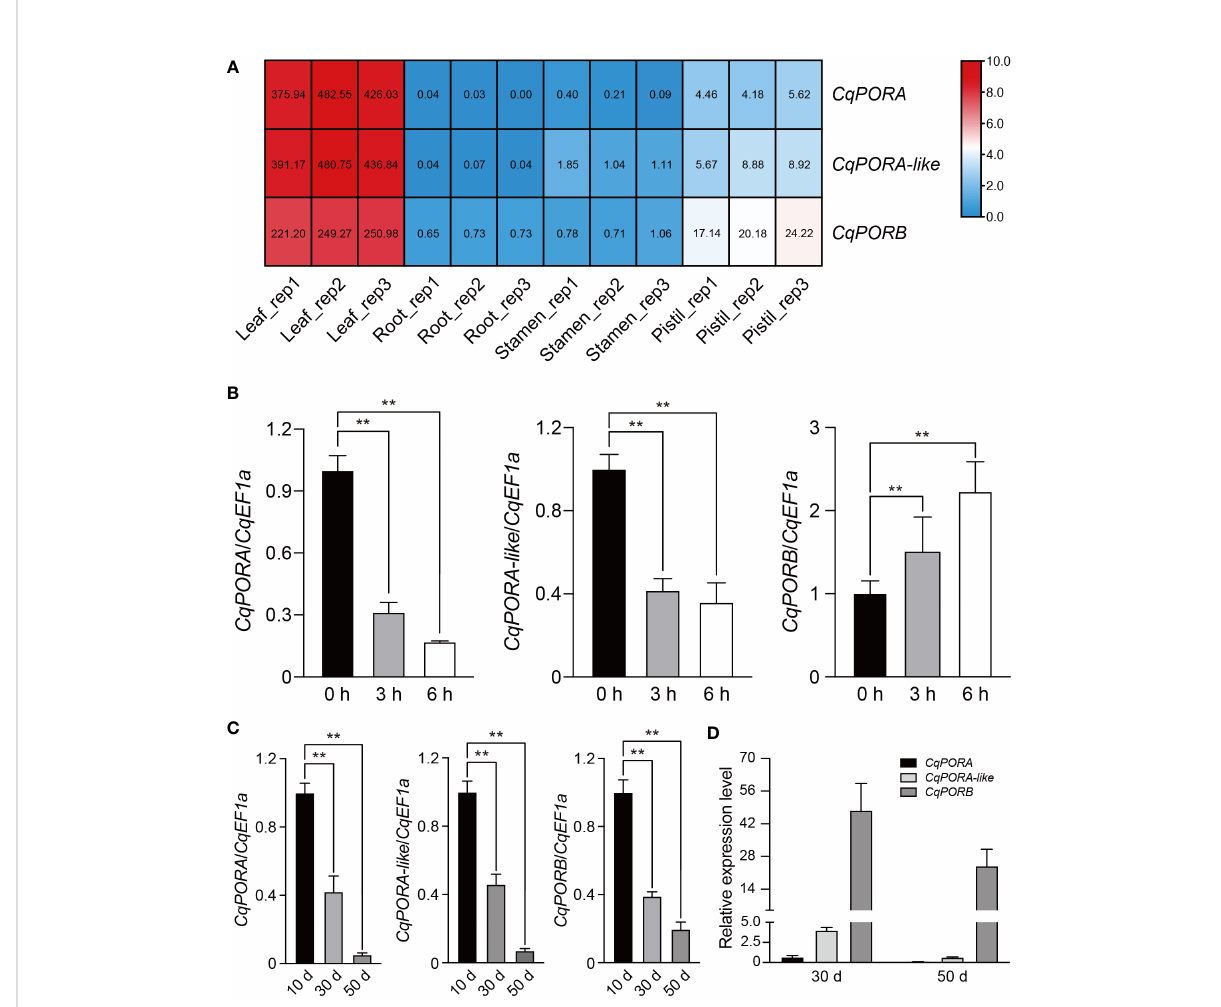
FIGURE 5 Expression patterns of POR genes in quinoa. (A) RNA-seq assay was performed for the leaf, root, stamen, and pistil tissues of NL-6 variety, and three independent replicates were conducted for each tissue. Different colors in the heatmap indicate the relative expression level of each CqPOR gene in different tissues based on log 2 -transformed FPKM. The FPKM values of CqPOR genes in four tissues are shown. (B) qRT-PCR analysis of the expression level of each CqPOR gene in etiolated seedlings after being exposed to white light for 0, 3, and 6 h. CqEF1a was used as an internal control. The transcript level of each CqPOR gene at 0 h was set as 1. Values are the means ± SD of three biological replicates. Asterisks indicate statistically signi fi cant differences (**p < 0.01, Student ’ s t -test). (C) qRT-PCR-analysis of the expression level of each CqPOR gene in NL-6 after growth on soils for 10, 30, and 50 days. CqEF1a was used as an internal control. The transcript level of each CqPOR gene at 10 d was set as 1. Values are the means ± SD of three biological replicates. Asterisks indicate statistically signi fi cant differences (**p < 0.01, Student ’ s t -test). (D) Comparison of the relative expression levels of the three CqPOR genes in NL-6 after growth on soils for 30 and 50 days. Values are the means ± SD of three biological